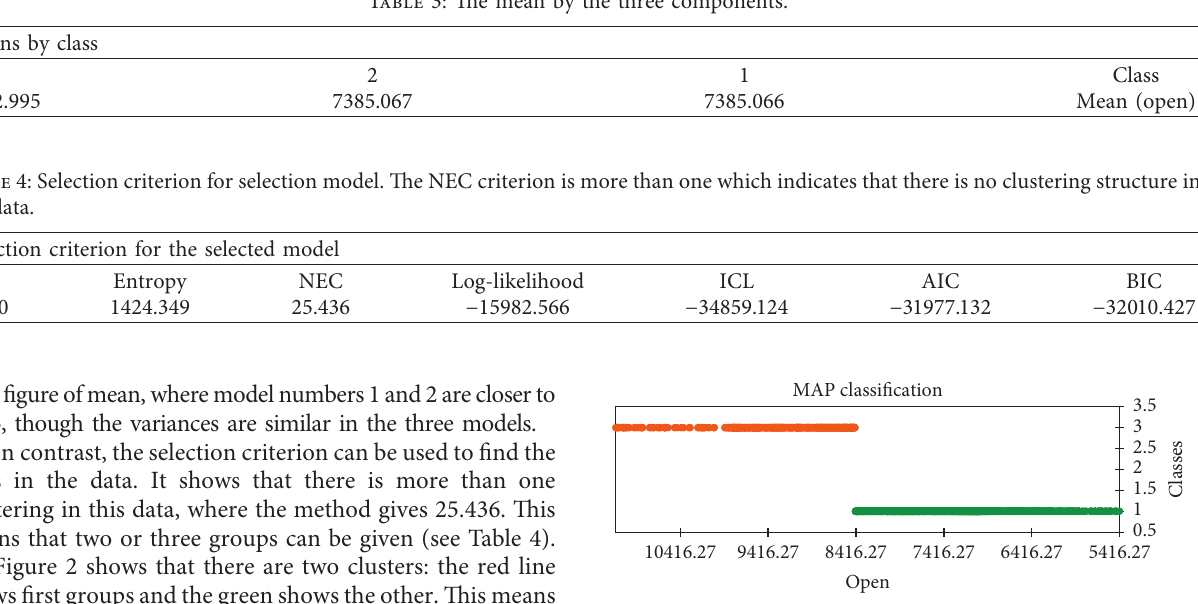
Figure 2: The MAP classification shows that there is no assignment to classes